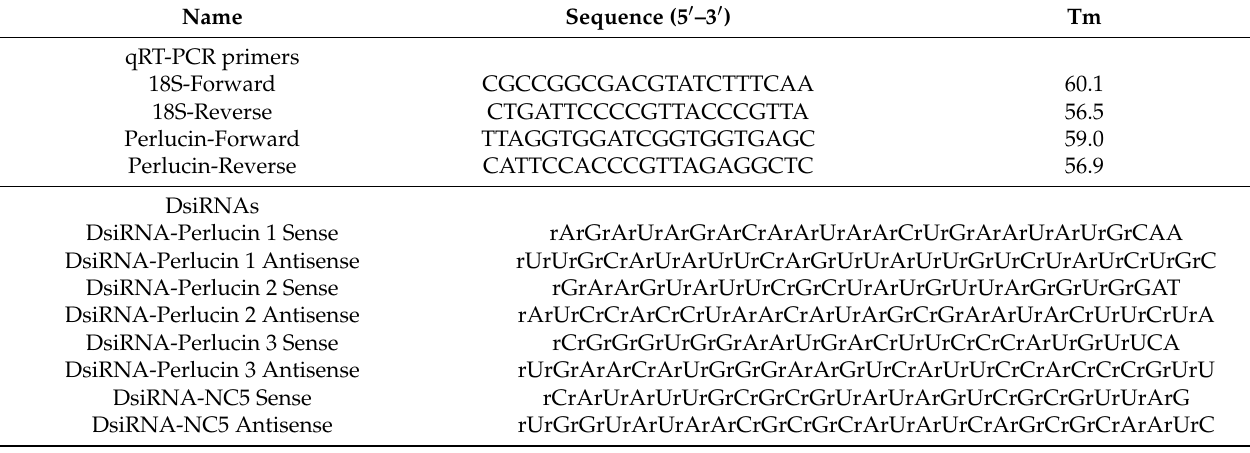
Table 1. Primers and DsiRNAs used in this study. The amplicon size of primers was 201 bp for 18S and 131 bp for perlucin.